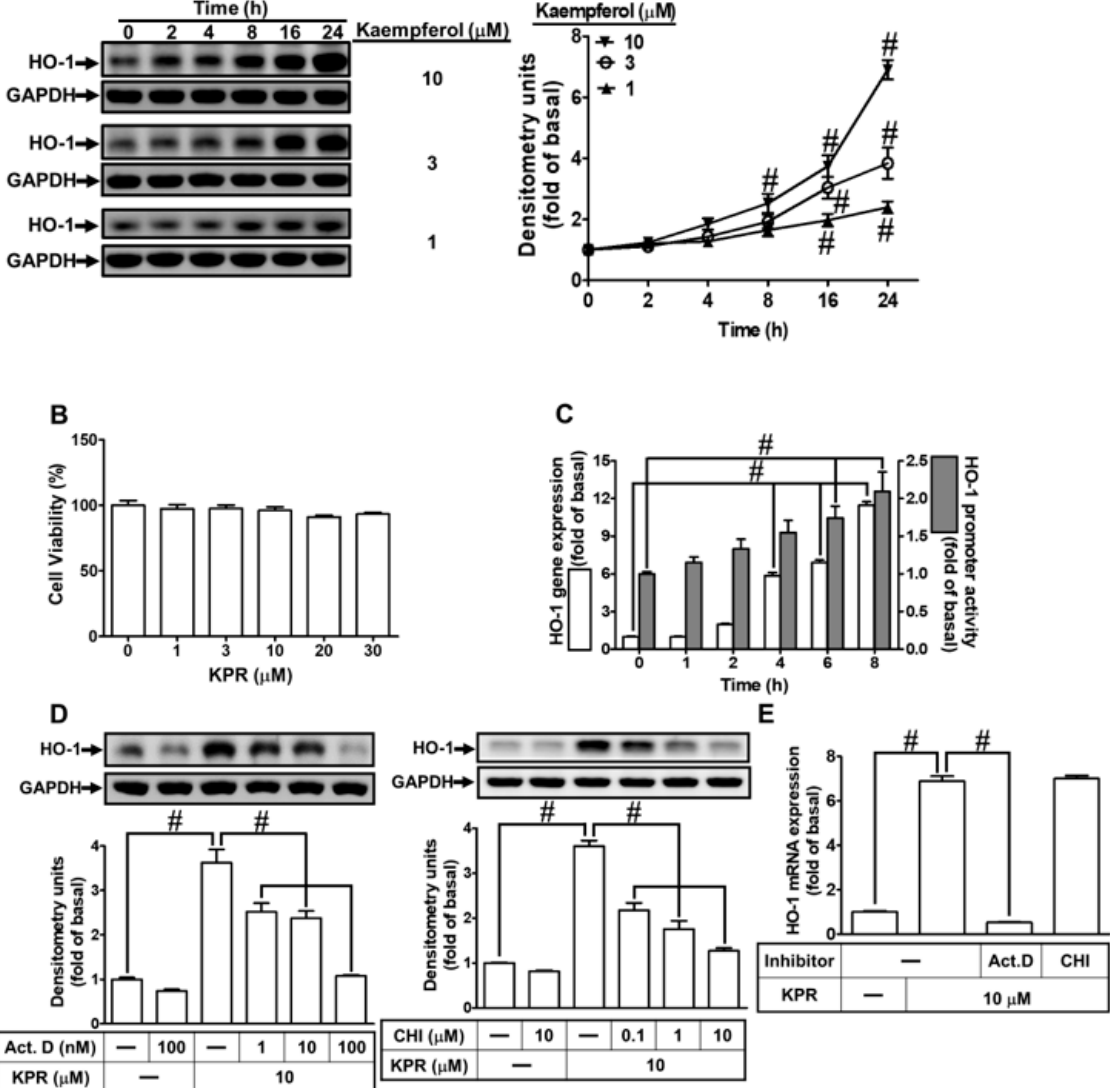
Figure 3. KPR induces HO-1 expression in HPAEpiCs. ( A ) HPAEpiCs were treated with various concentrations of KPR for the indicated time intervals. The protein expression of HO-1 was determined by Western blot using GAPDH as a loading control. ( B ) Cells were treated with various concentrations of KPR for 24 h and the cell viability was examined by an XTT kit. ( C ) HPAEpiCs were treated with KPR (10 μ M) for the indicated time intervals. The HO-1 mRNA expression and promoter activity were analyzed by real-time PCR and promoter activity assay kit, respectively. ( D ) HPAEpiCs were preincubated with various concentrations of either Act. D or CHI for 1 h and then incubated with vehicle or KPR (10 μ M) for 16 h. The levels of HO-1 protein expression were determined by Western blot using GAPDH as a loading control. ( E ) Cells were pretreated with/without 100 nM Act. D or 10 μ M CHI for 1 h, and then incubated with DMSO or KPR (10 μ M) for 6 h. The level of HO-1 mRNA expression was analyzed by real-time PCR. Data are expressed as mean ± SEM ( n = 5), analyzed with one way ANOVA and Dunnett’s post hoc test. # p < 0.01, as compared with the cells exposed to vehicle alone; or significantly different as indicated.